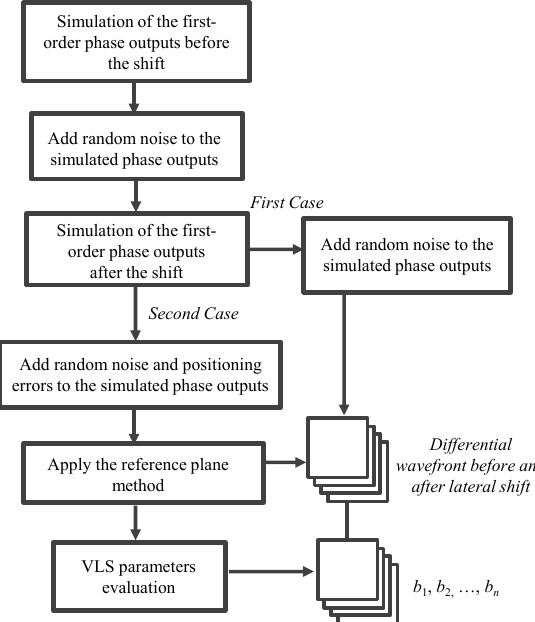
Figure 7. Flow diagram of the simulation procedure.